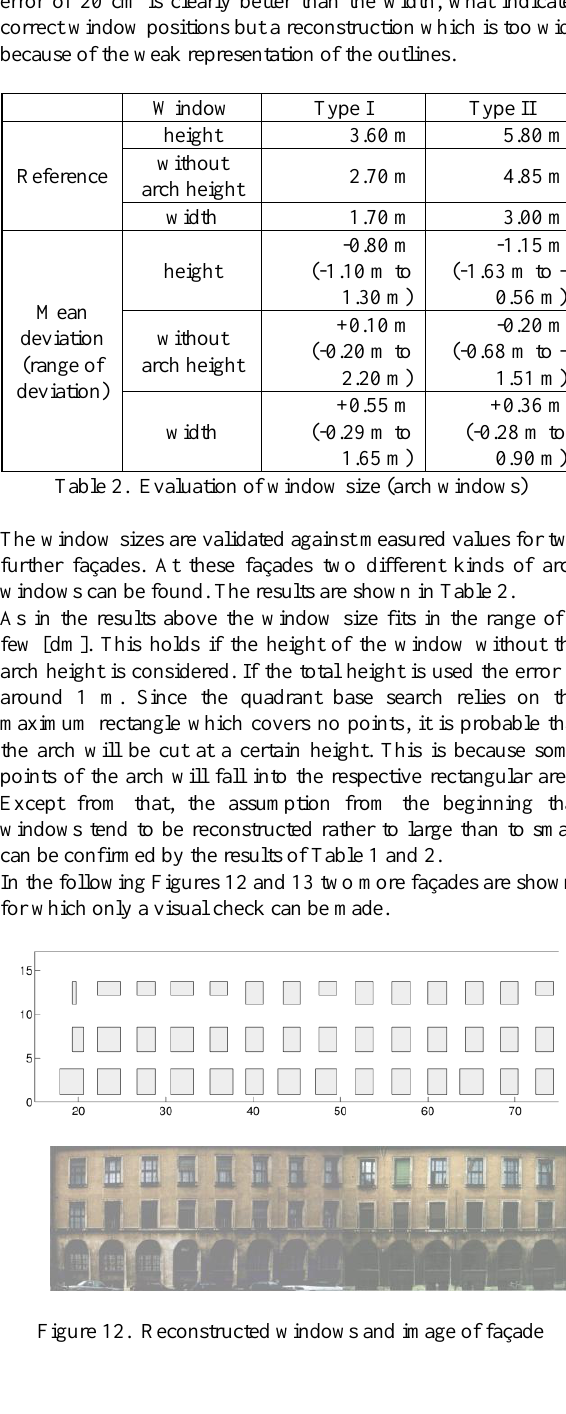
Figure 13. Reconstructed windows and image of façade